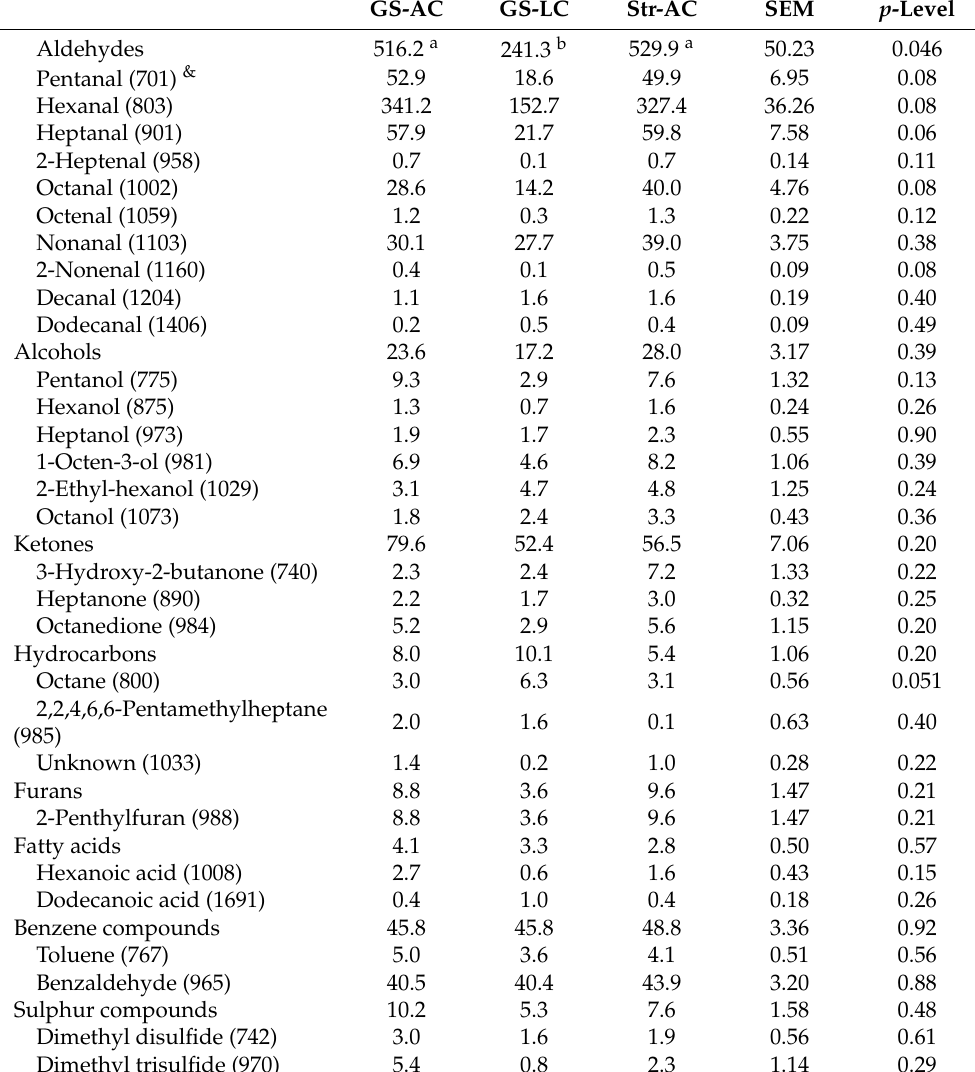
Table 3. Major headspace volatile compounds (ng equivalents of undecane/mL) in cooked longis- simus thoracic muscle from young Tudanca bulls reared under different feeding